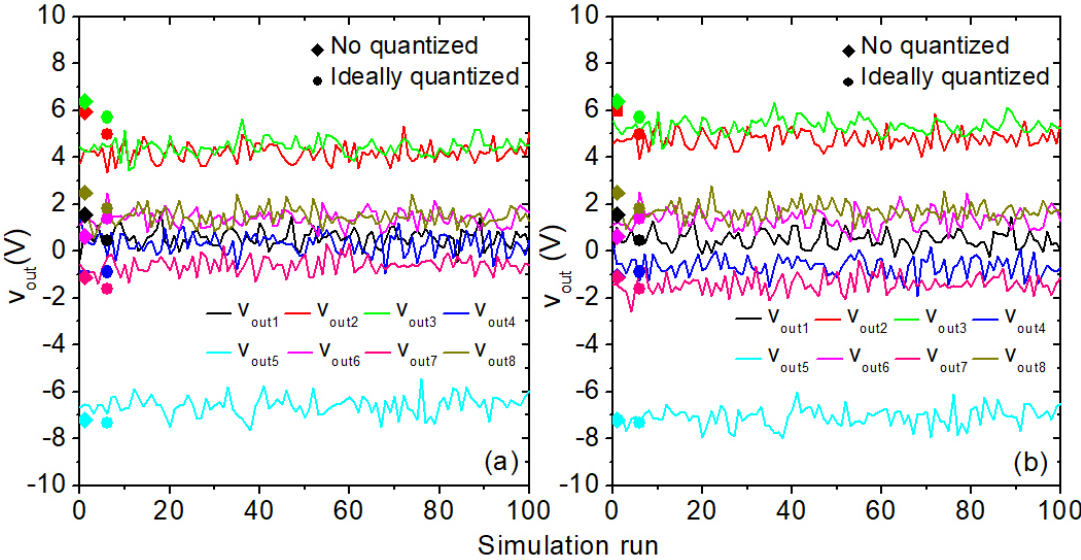
Figure 7. Results of 100 Monte Carlo simulations of a VMM operation for a given input vector and a given weights matrix (solid lines), when using the non-optimized ( a ) and the optimized ( b ) combination of M-ISPVA parameters. The exact results calculated with no quantized weights (square symbols and dashed lines) and the results calculated with ideally quantized weights (circle symbols) are included for